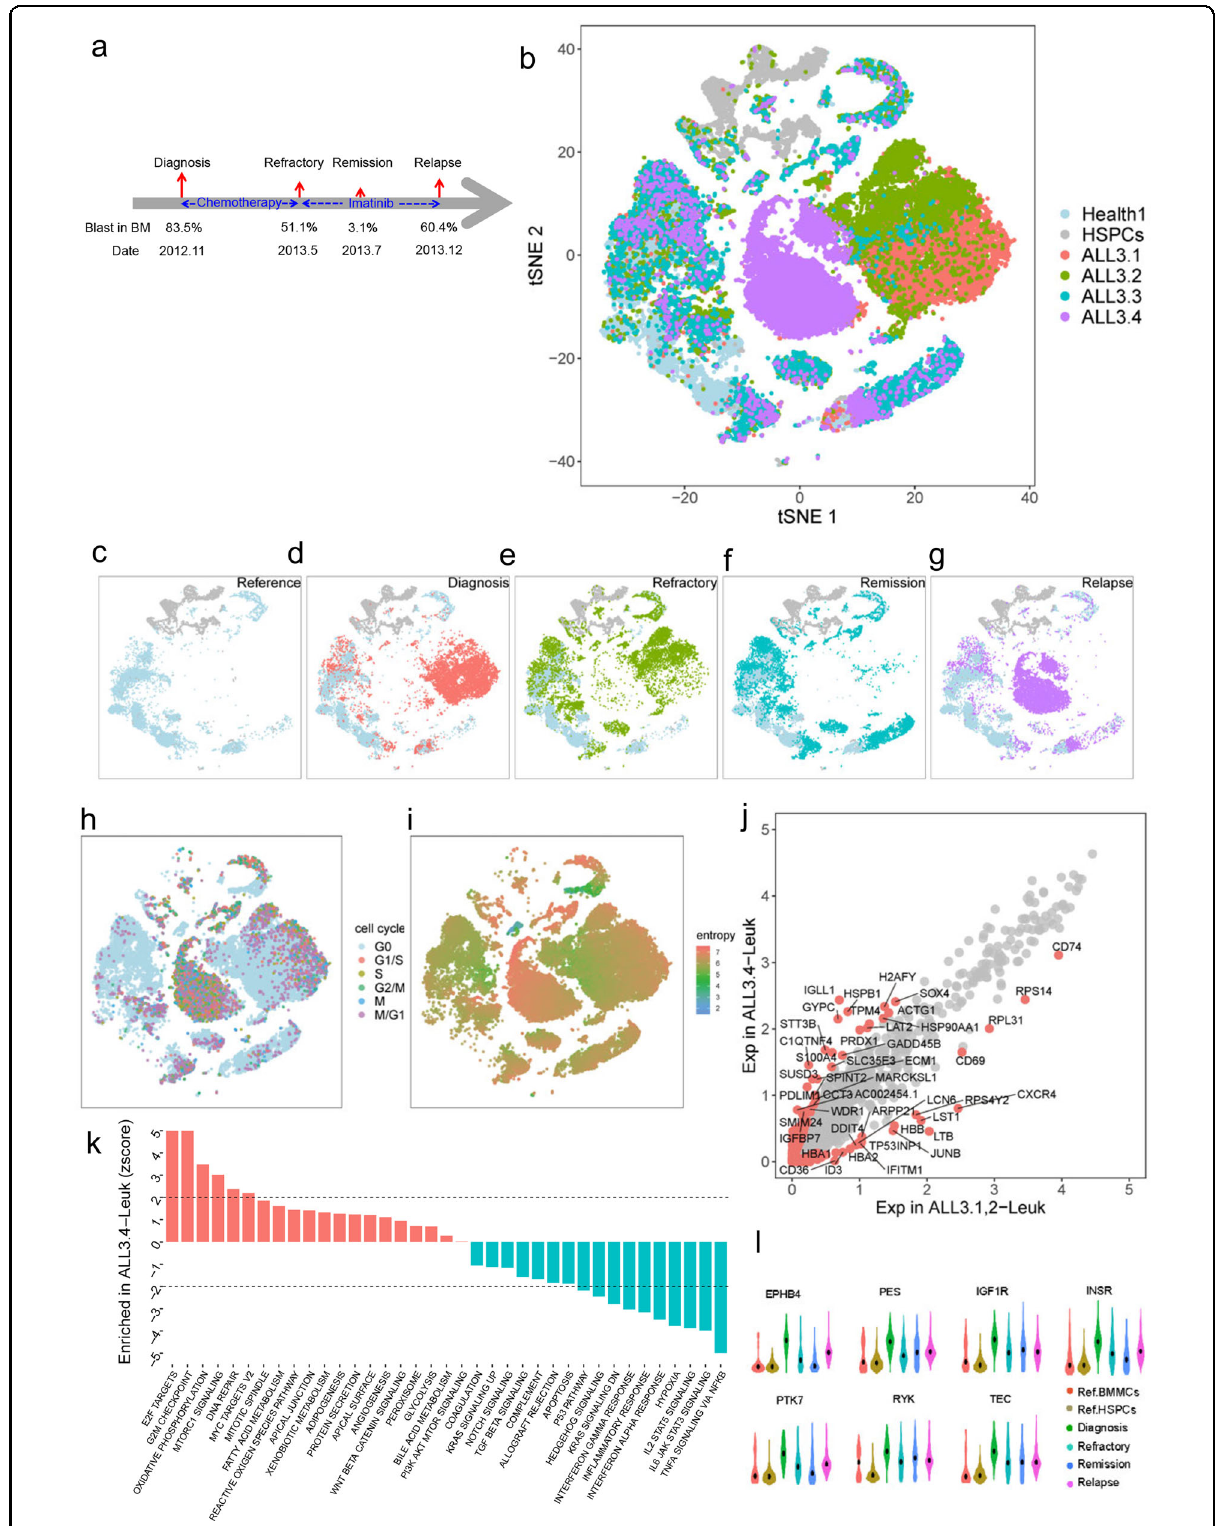
Fig. 5 (See legend on next